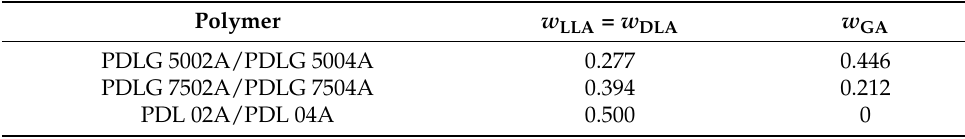
Table 2. Monomer composition (as mass fractions) in the copolymers